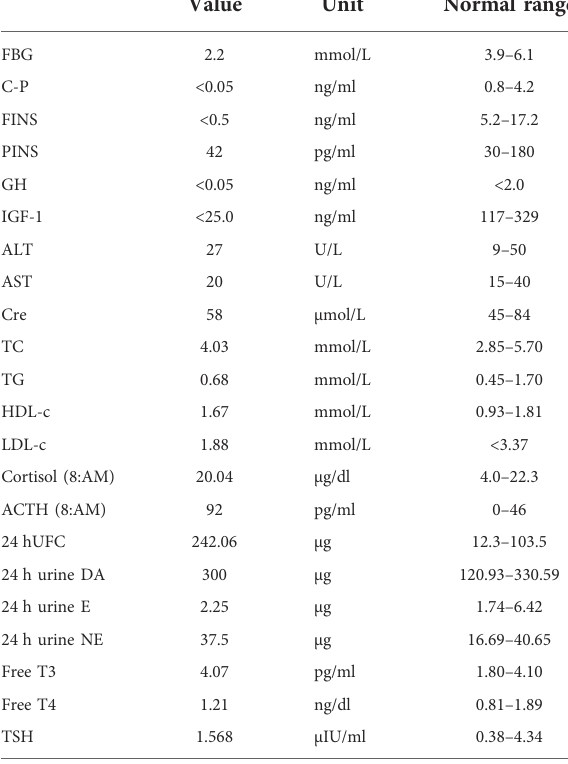
TABLE 1 Laboratory fi ndings on